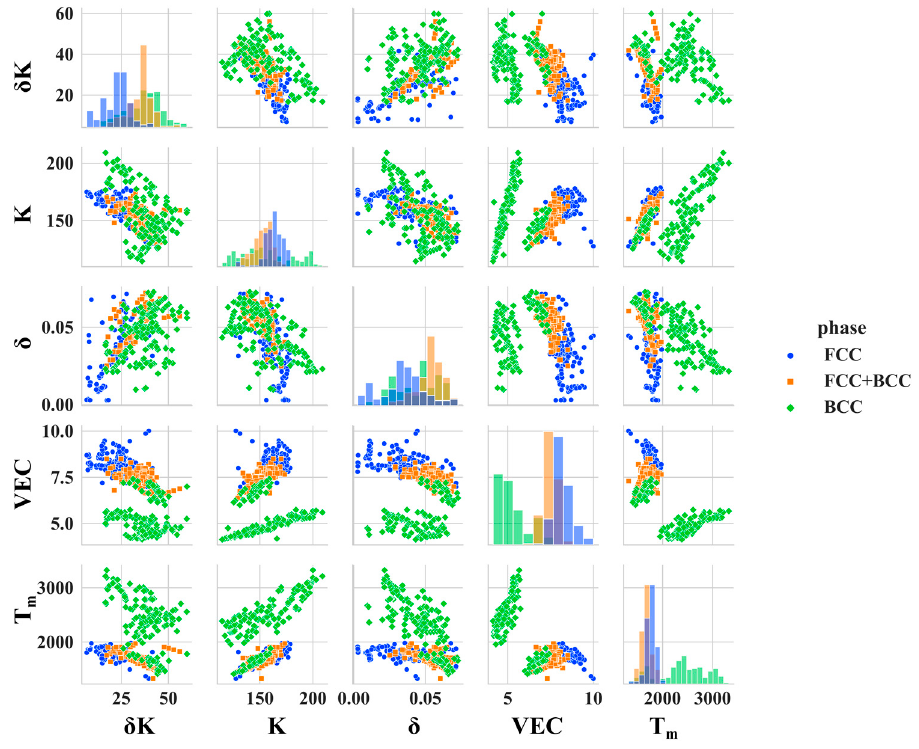
Figure 4. Scatter plot of the features for three phases. Scatter plots show the distributions of the three phases as a function of a pair of the 5 features. Histograms present the distributions of the three phases at different values of one of the 5 features. Different colors indicate different phases. Blue is for FCC, green for BCC, and orange refers to FCC + BCC.